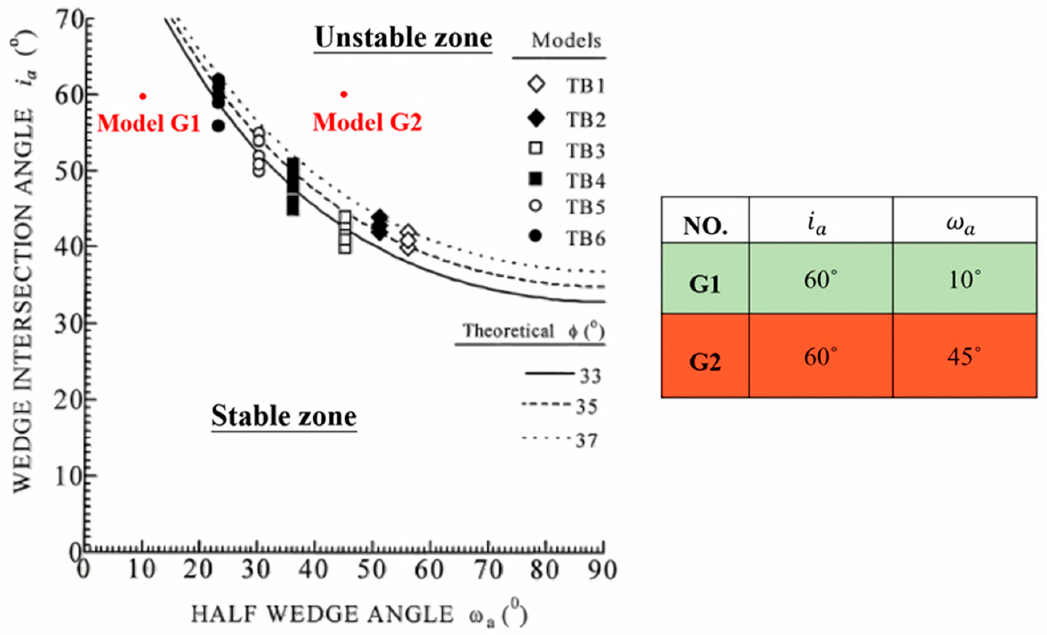
Figure 18. Comparison of the study models and Kumsar’s model.